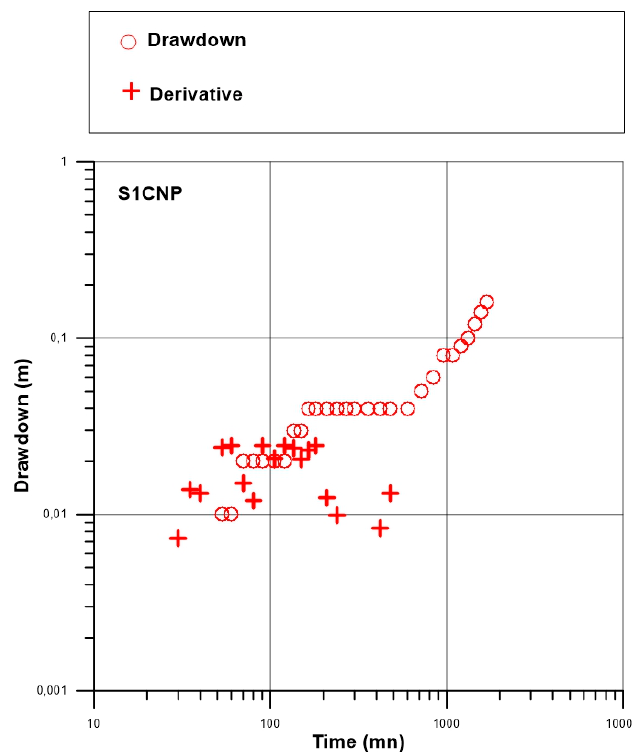
Figure 6. Observed drawdown and its derivative in observation well S1CNP.